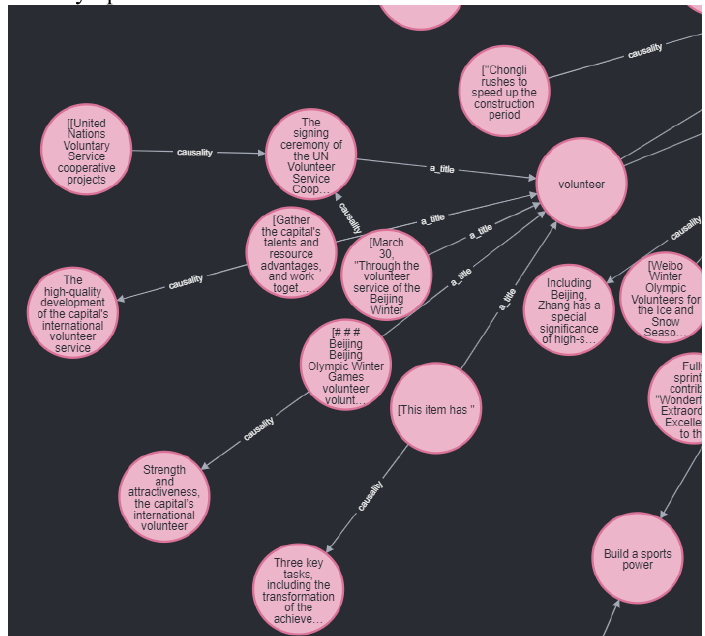
Fig. 8. The discussion graph of Microblog users on the topic of